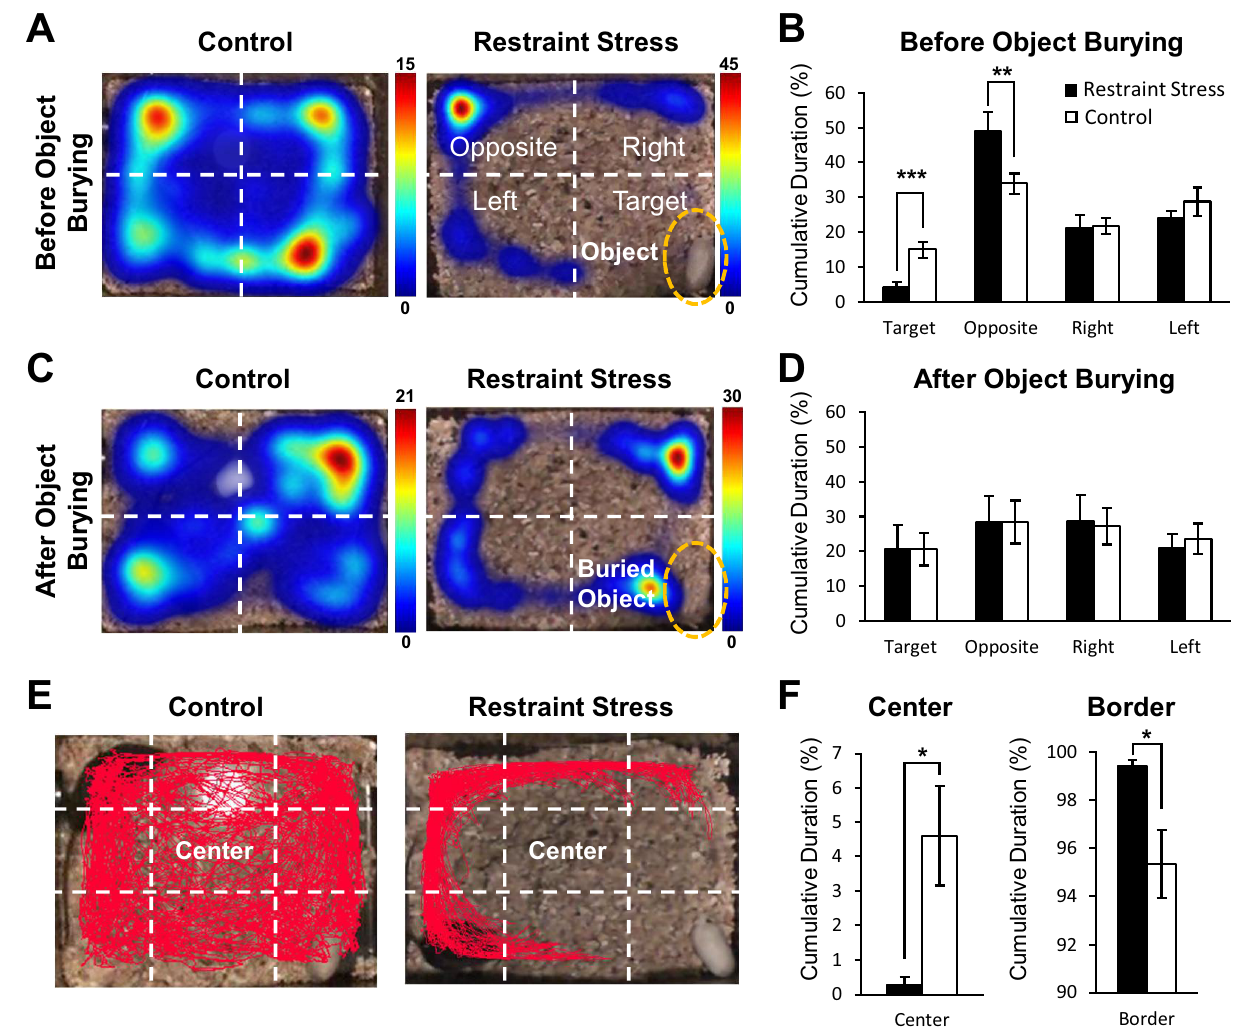
Figure 2. Anxiety-like behavior exhibited in mice exposed to restraint stress. ( A, C ) An experimental cage was divided into four quadrants—opposite (furthest zone from where a restrainer-resembling object was placed), right, left, and target (the zone where a restrainer-resembling object was placed) zones—to analyze differences in movement trajectory between groups. Color scale on the right of each heat map denotes the dwell duration measured in seconds: the hotter the color, the longer the dwell duration. ( A ) Representative heat map analysis showing cumulative dwelling time in the experimental cage of each group before a restrainer- resembling object was buried (0–5 min after experiment). ( B ) Comparison of cumulative duration in respective quadrants between groups before a restrainer-resembling object was buried (0–5 min after experiment). ( C ) Representative heat map analysis showing cumulative dwelling time in the experimental cage of each group (from same animals shown in A) after a restrainer-resembling object was buried (10–15 min after experiment). ( D ) Comparison of cumulative duration in respective quadrants between groups after a restrainer-resembling object was buried (10–15 min after experiment). ( E ) Example trajectory of a control and stressed mice. Red line indicates trajectory of a mouse during the test. White dashed lines divide each experimental cage into the center and border zone. ( F ) Cumulative duration in the center or border zone between groups. ( B, D, F ) All data are presented as mean ± SEM. Student’s t-test was used to compare means between the stress and the control group. *p < 0.05, **p < 0.01, ***p < 0.001. ( A–F ) All the behavioral analyses were performed with data acquired from the first experiment (day